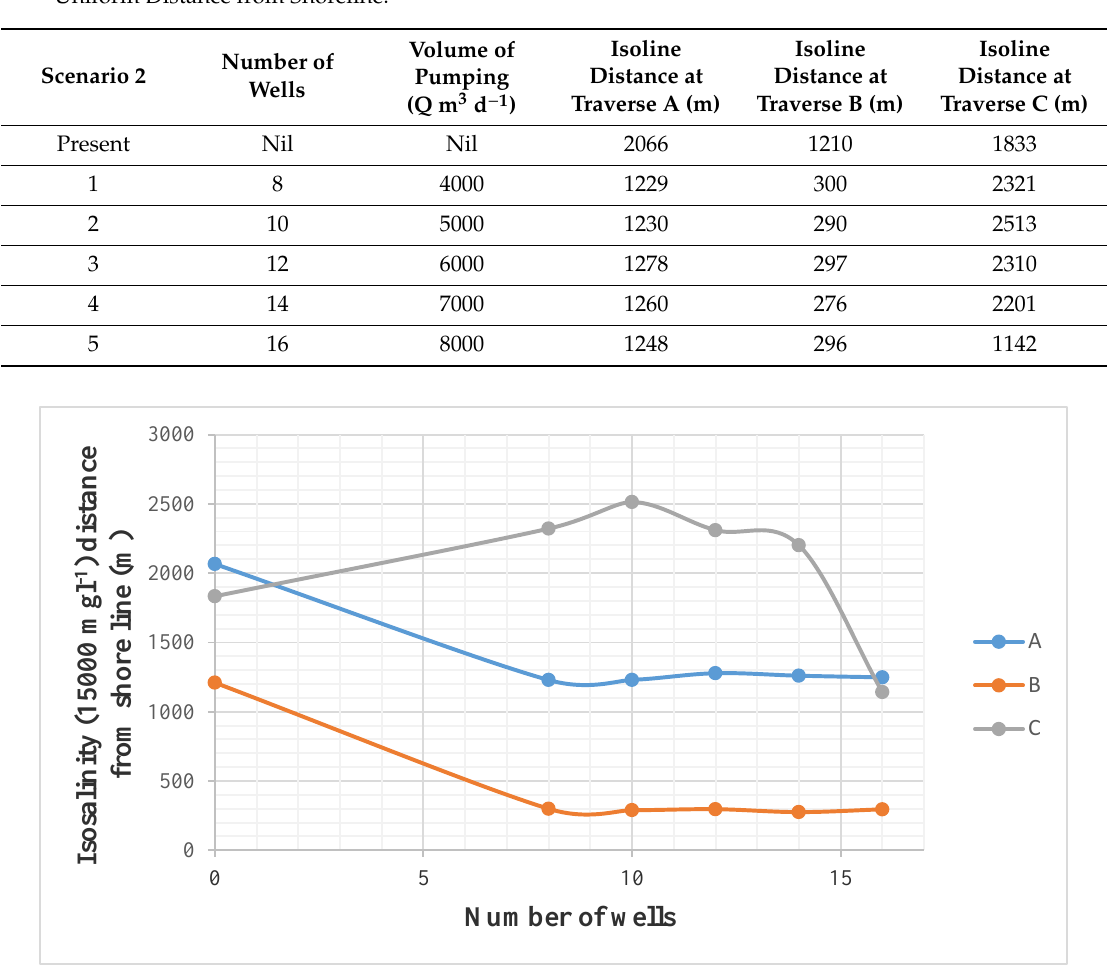
Figure 11. Location of 15,000 mgl − 1 isosalinity contour line along A, B and C after 4018 days of simulation.